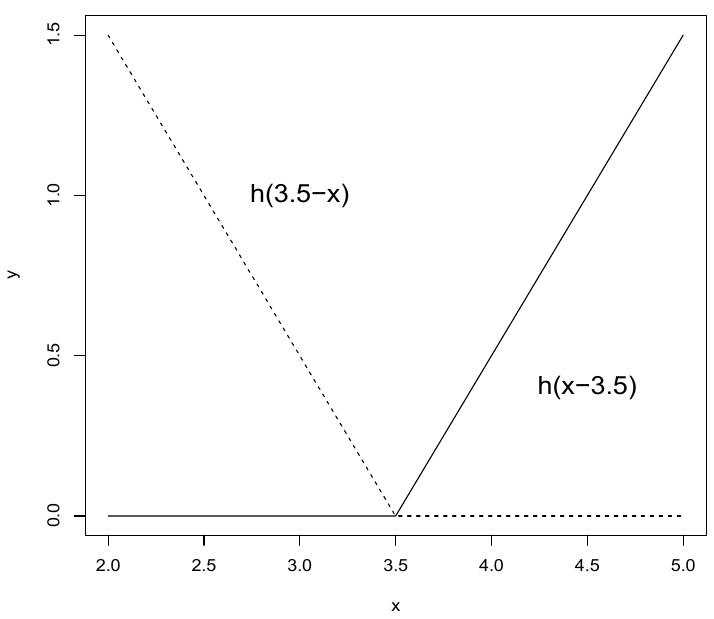
  x t   ) is   x t   ) as a solid line.